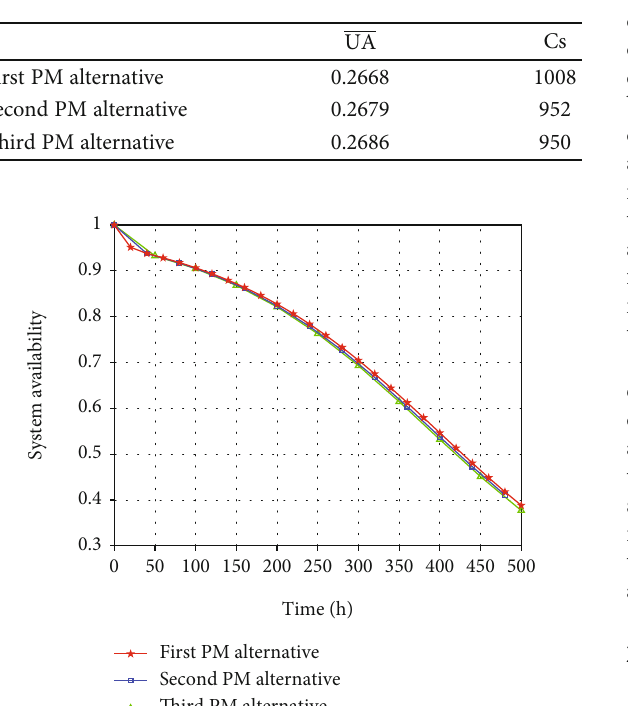
Table 1: Three PM alternatives with mean system unavailability and total maintenance cost.